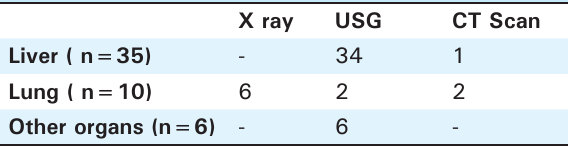
Table 4. Type of radiological imaging done in all cases. X ray USG CT Scan